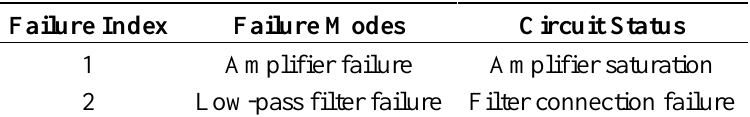
Table 1. Failure